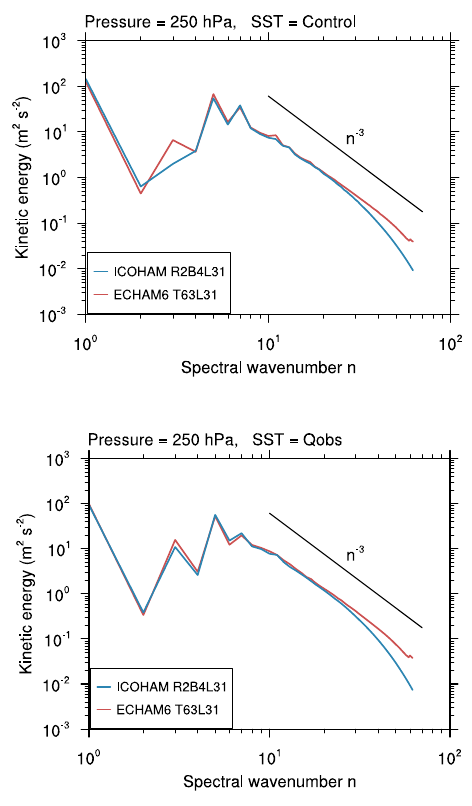
Fig. 16. 250hPa kinetic energy spectra in the aqua-planet simu- lations performed with ICOHAM at R2B4L31 resolution and with ECHAM6 at T63L31. The upper panel shows results obtained with the “Control” SST profile. The lower panel corresponds to the “Qobs” profile. The spectra are diagnosed from daily output of in- stantaneous vorticity and divergence fields. Each curve shown in the figure is an average of 800